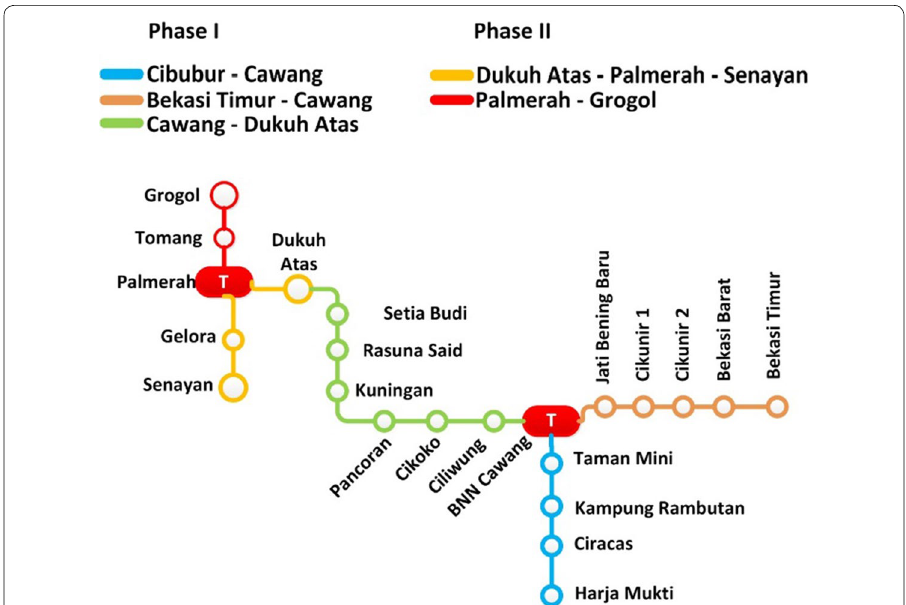
Fig. 2 Planning of greater Jakarta LRT